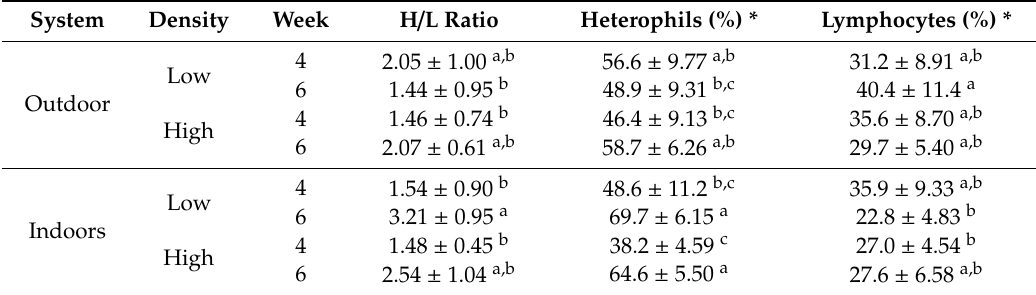
Table 6. LS Means of the e ff ects of system × density × week on stress indicators of commercial-line broilers 1 .